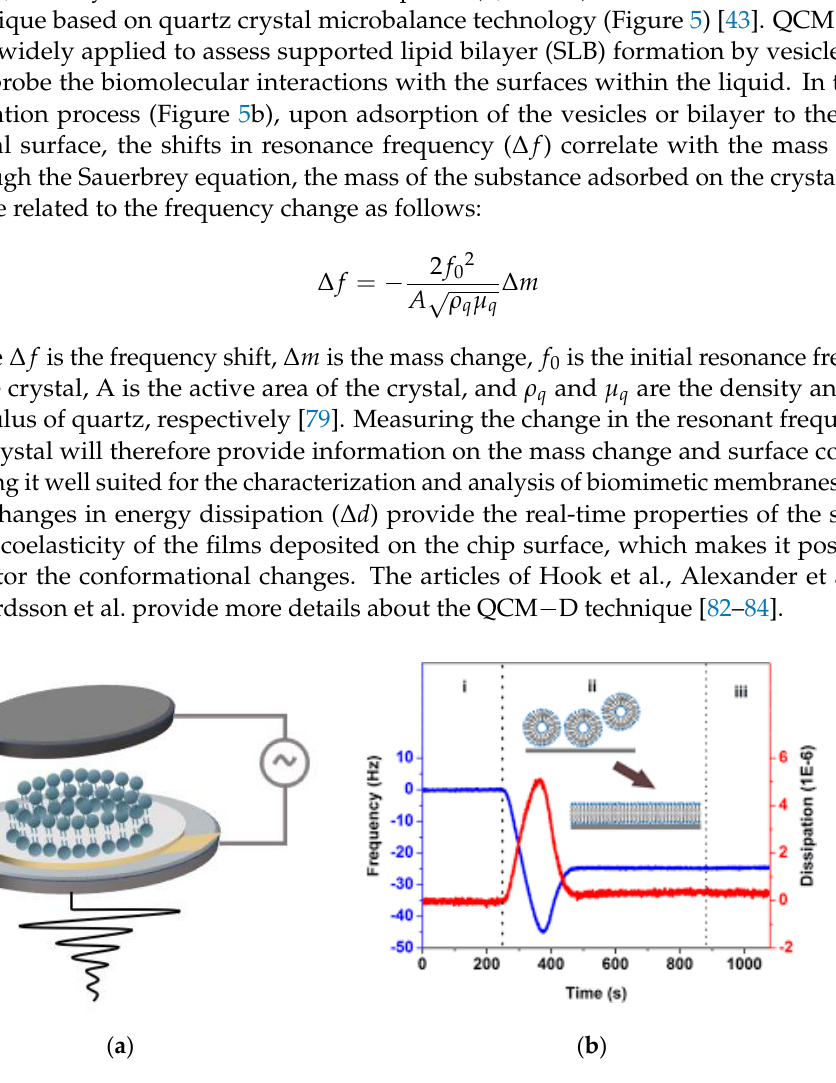
Figure 5. ( a ) Schematics of the quartz crystal microbalance method. The crystal resonates in shear mode. The shear wave in the sample and the environment, generated by the motion of the crystal, decays in a short distance due to energy loss via dissipative processes. ( b ) The representative frequency (blue) and dissipation shifts (red) of QCM − D during the formation of the SLB [85]. (i. Rinsing the sensor chip with buffer ii. Bilayer formation iii. Rinsing the bilayer with buffer). Reprinted with permission from [85], Copyright 2019 ACS Publications.